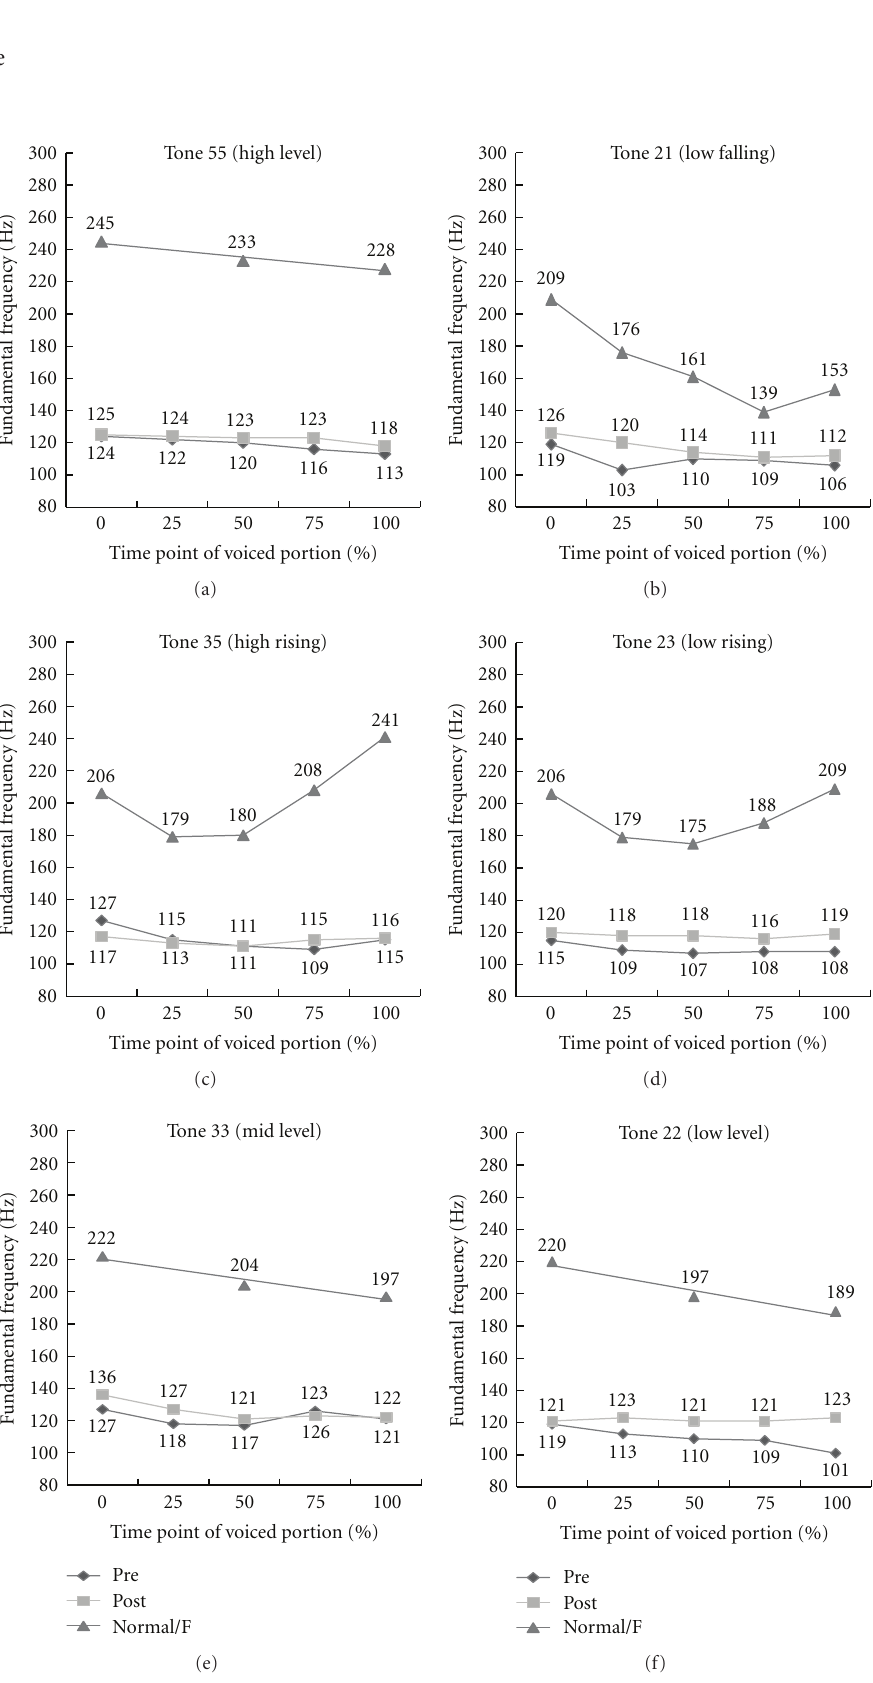
Figure 3: F0 pattern of six lexical tones produced by a 78-year-old female, HYH. The normative data are from Whitehill et al. [21, 22], cited in Whitehill and Wong